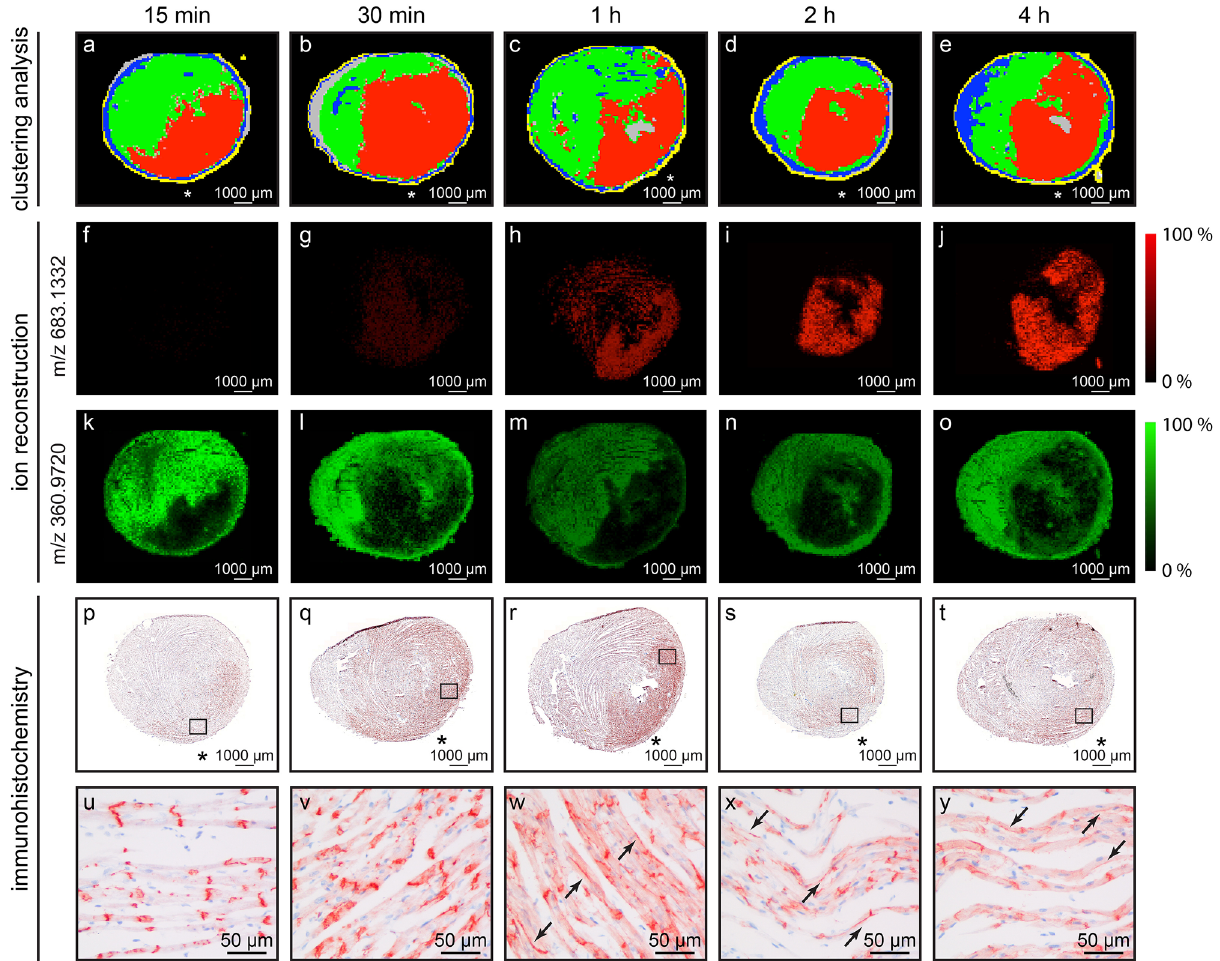
Figure 1. User-independent segmentation of the data separated the predicted ischemic region into its own cluster and this ischemic cluster corresponded to area positive for Cx43 changes. ( a – e ) Diagrams of cluster analysis (k = 6) from selected samples at 15 min, 30 min, 1 h, 2 h, and 4 h ischemia; colours represent clusters; n = 5 per time point (biological replicates); red cluster corresponds to the predicted ischemic area; asterisks (*) indicate anterior left ventricle. ( f – j ) Reconstructed ionic image from selected samples showing distribution and intensity of m/z 683.1332 (non-annotated feature in the ischemic red cluster); n = 5 per time point (biological replicates); abundance is represented by colour: black and red corresponding to low and high abundance, respectively. ( k – o ) Reconstructed ionic image from selected samples showing distribution and intensity of m/z 360.9720 (non-annotated feature in the non-ischemic green cluster); abundance is represented by colour: black and green corresponding to low and high abundance, respectively. ( p – y ) Change in Cx43 localization in response to ischemia: ( p – t ) Overview of entire cross sections from hearts exposed to 15 min, 30 min, 1 h, 2 h, and 4 h ischemia stained by immunohistochemistry using an antibody that recognizes multiple phospho-forms of Cx43; ( u – y ) View at higher magnification of the area highlighted by black rectangles in ( p – t ); lateralization and increased cytoplasmic staining was observed starting 1 h; arrows indicate localization of Cx43 to the lateral side of